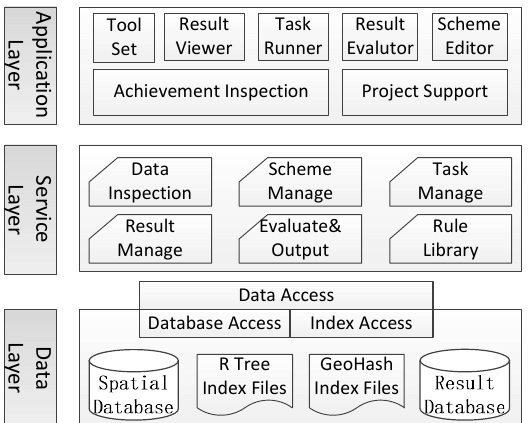
Figure 3. Instantiation and working step for inspection